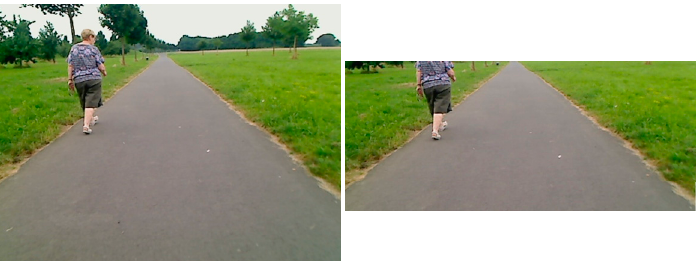
Figure 3. Image after ROI cropping.